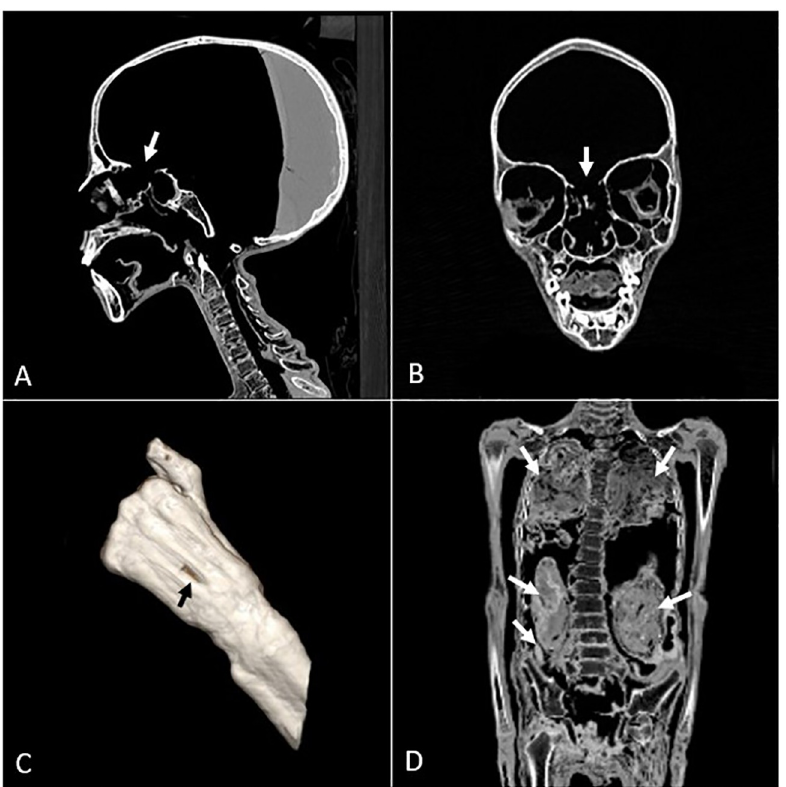
Fig 3. CT scan images of the mummies. A—trans-nasal craniotomy in the form of an anterior skull base defect and solidified resin inside the skull of the older mummy; B—anterior skull base defect in the younger mummy; C—linear skin defect on the back of the left hand of the older mummy; D—torso of the younger mummy showing folded textiles inside the thoracic cavity, as well as textile bundles and a small oval object inside the abdomen.